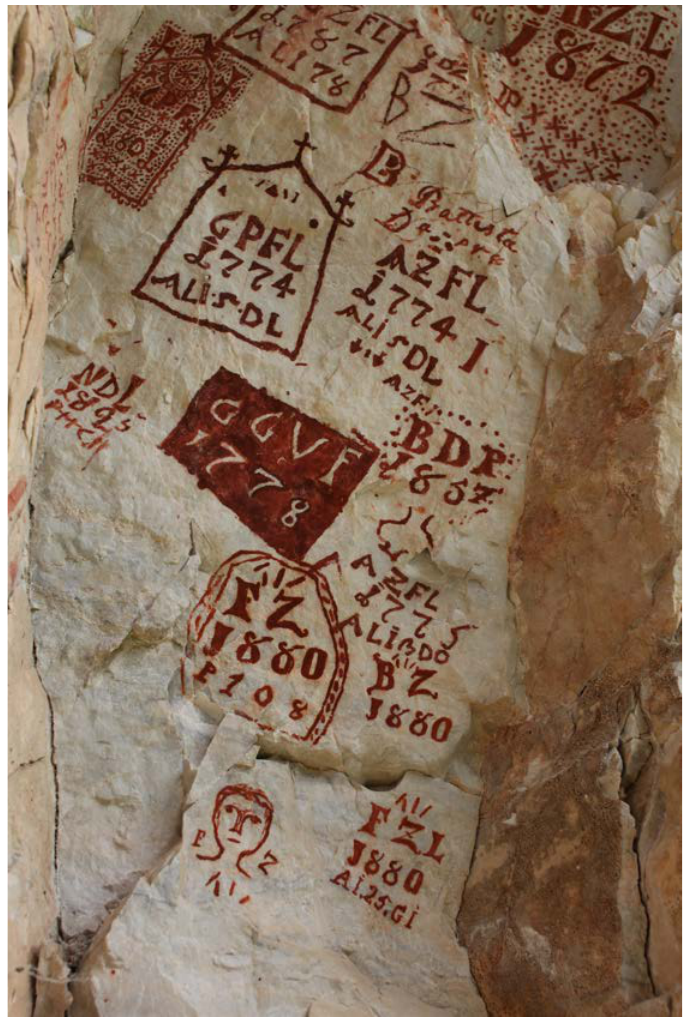
Figure 6 – Fiemme Valley, Mount Cornón: example of writing of the first period. Courtesy of Museo degli Usi e Costumi della Gente